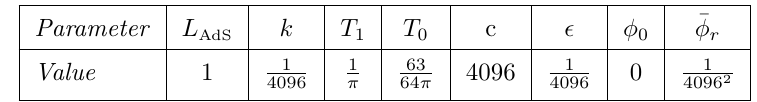
Table 1 . Baseline parameters for all numerical plots in this